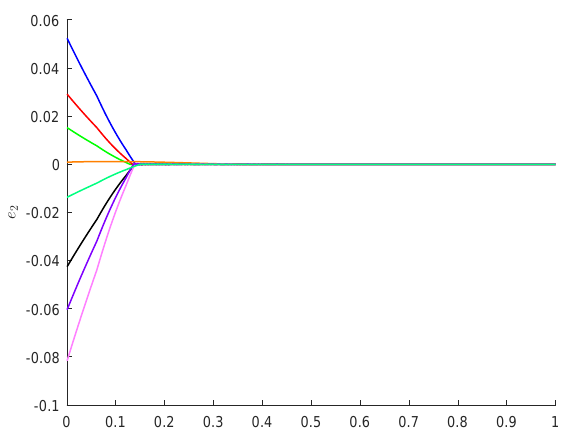
Figure 5. State trajectories of the error e 2 in Example 2, for 8 initial values (depicted with different colors). Best viewed in color.